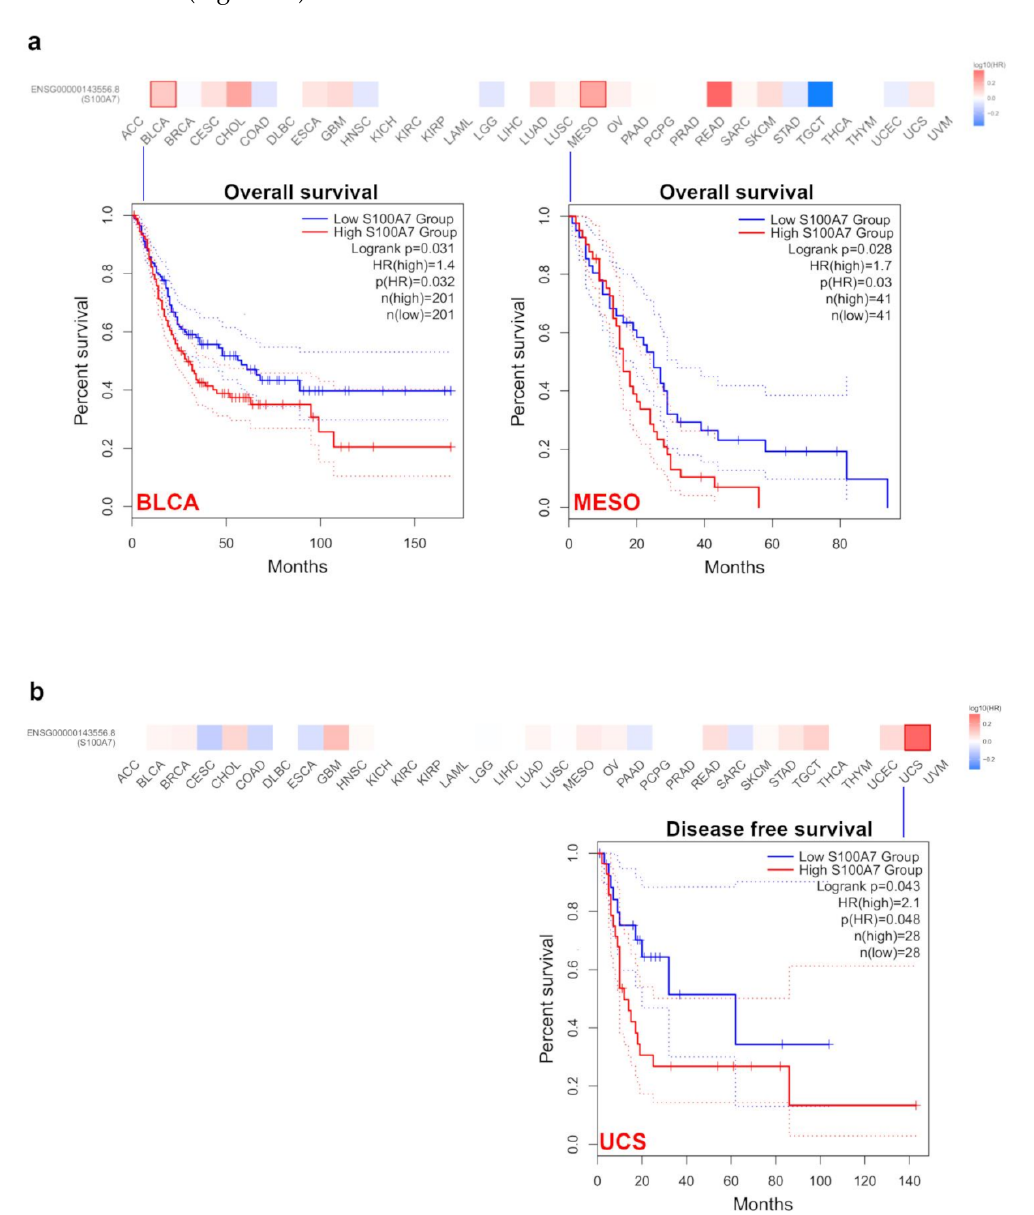
Figure 2. S100A7 gene expression is correlated with survival prognosis of the TCGA tumors. ( a ) Correlation of S100A7 gene expression with overall survival of various TCGA tumors. ( b ) Corre- lation of S100A7 gene expression with disease-free survival of various TCGA